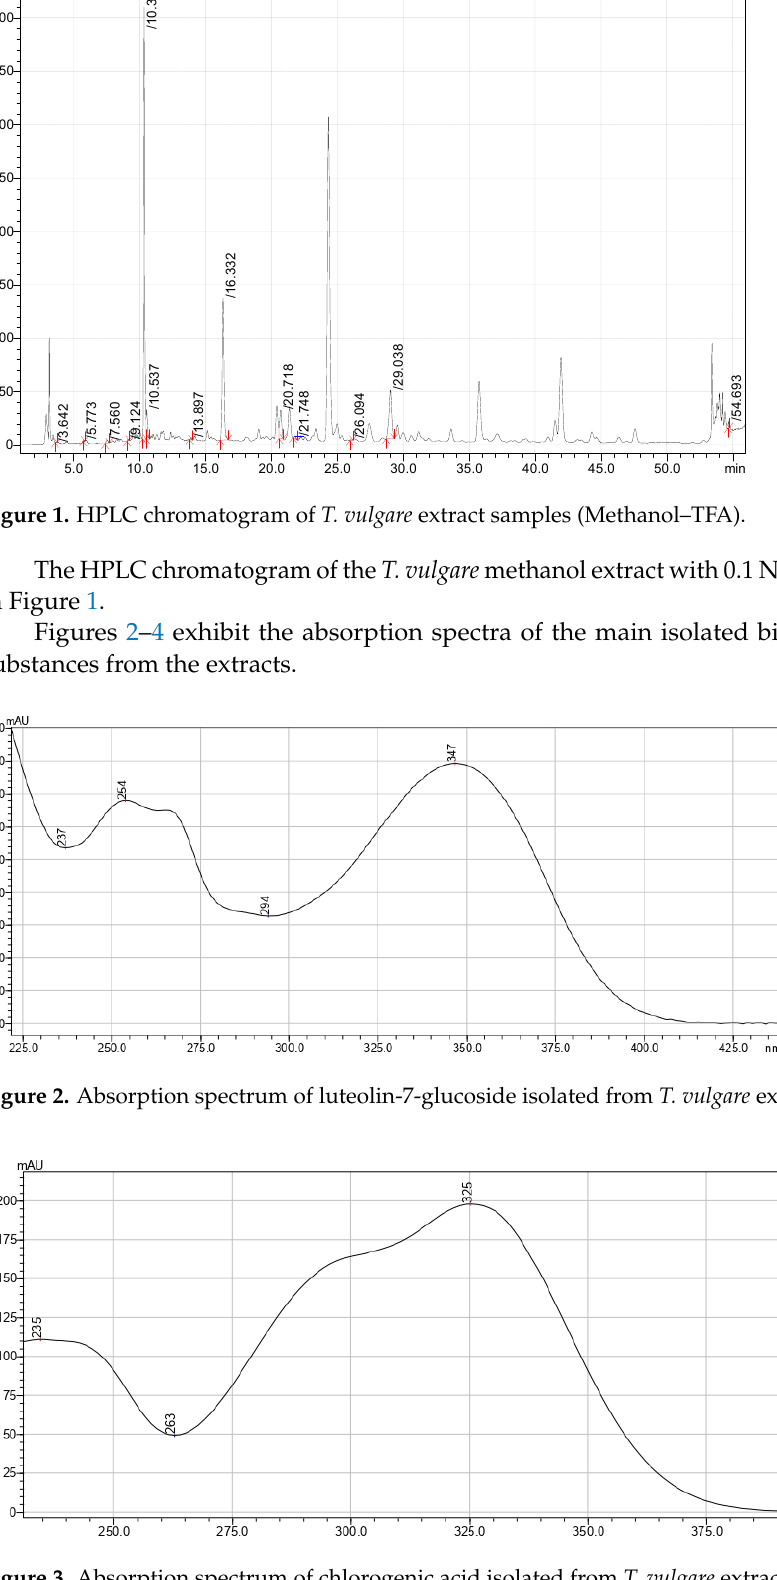
Figure 4. Absorption spectrum of rosmarinic acid isolated from T. vulgare extracts. Figure 5 shows the structural formulas of the main HPLC ‐ identified (by retention time and absorption spectra) BASs from T. vulgare extracts. ( a )